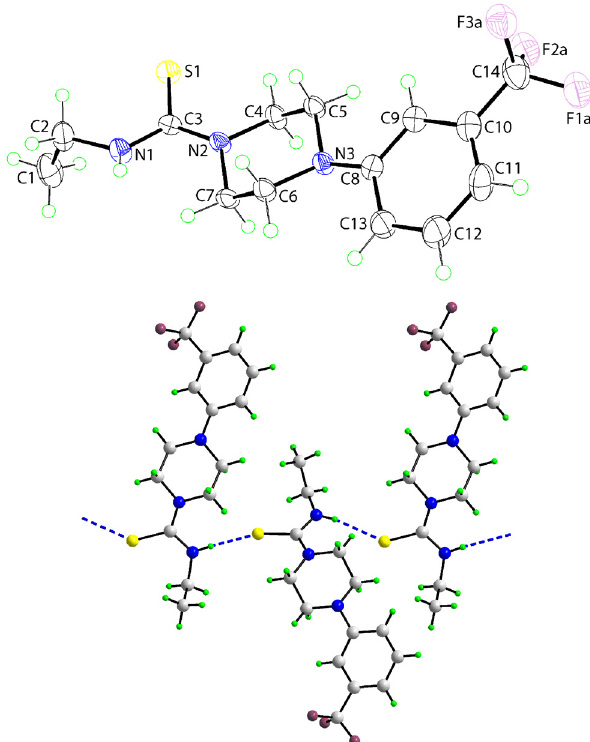
Table  : Data collection and